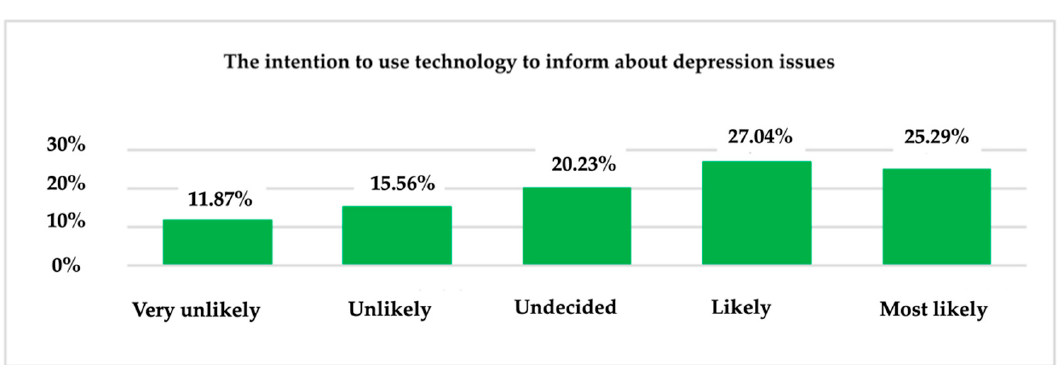
Figure 15. The intention of using technology—measurement, storage, and transmission of medication data. Regarding the use of technology in the future for access, storage, and transfer of personal health data to a doctor, 25.88% of respondents are undecided. Moreover, the